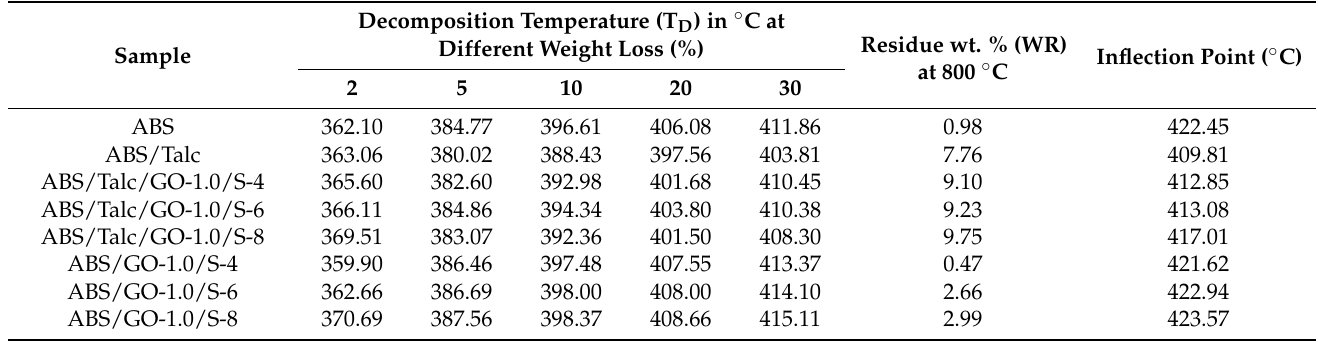
Table 6. Thermogravimetric analysis (TGA) data of ABS and ABS/talc composites with different loading amounts of